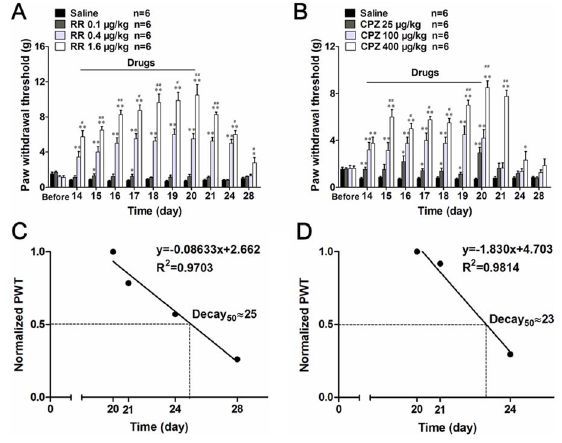
Figure 8. Multiple intrathecal applications of TRPV1 antago- nists cumulatively antagonize mechanical allodynia. A and B , long-term effects of multiple applications of ruthenium red and capsazepine for consecutive 7 days (n=6). C and D , reconstruction of the decay response diagram from A and B after the withdrawal of RR ( A ) and CPZ ( B ) (n=6).The value in longitudinal axis was normalized by the thresholds value on DMA 20 d. The linear regressions were performed to calculate the decay rates and to evaluate the half decay times (‘Decay 50 ’), and the results are shown above the plots. * P , 0.05, ** P , 0.01 vs . vehicle control of the same time. # P , 0.05, ## P , 0.01 vs . drugs of middle dose.